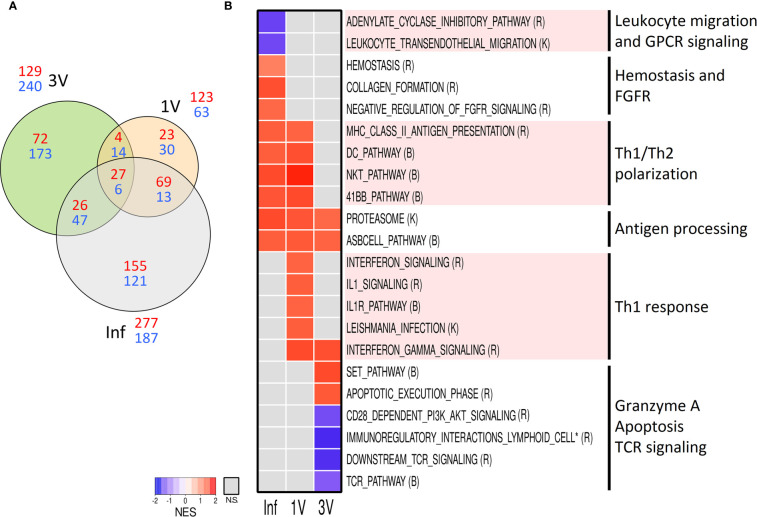
Evaluation of gene expression in sdLN by Microarray analysis. (A) The shared and unique elements of sdLN Microarray data showing the DEGs of Inf, 1V and 3V groups at Day 5 represented in a Venn Diagram (red: up regulated, blue: down regulated) (FDR not adjusted, p <0.001); (B) Heatmap of GSEA pathways (p <0.05) in sdLN from Inf, 1V and 3V groups at Day 5. Data derived from Cross-Sectional assay ➁ (nine mice per group). Three biological replicates were assessed per group per time point, in which each individual biological replicate consisted of a pool of sdLN RNA from three mice (
Supplementary Table 2
). Pathway databases: (R) Reactome, (B) Biocarta, (K) KEGG.